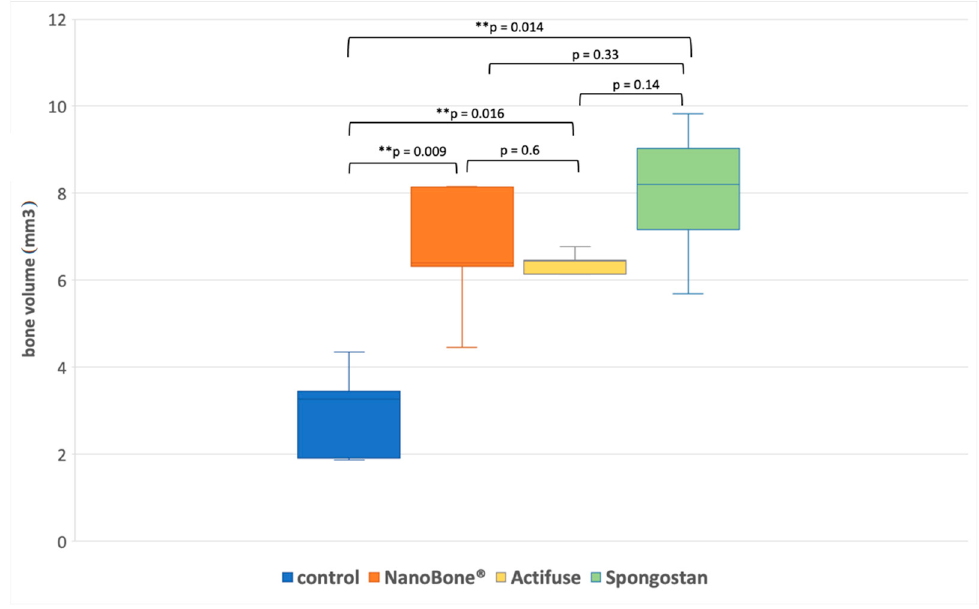
Figure 4. Box ‐ plot diagram of the newly formed bone volume with respect to the treatment group.